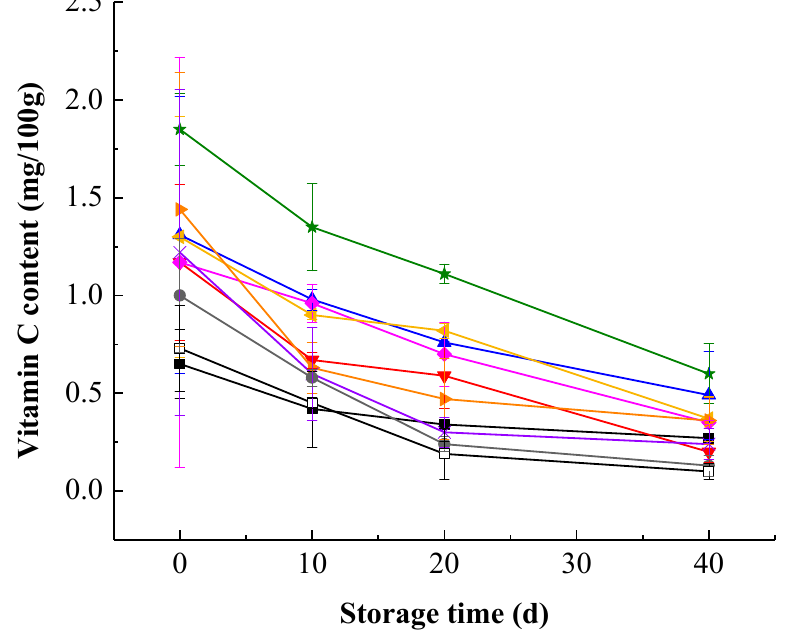
Figure 2. Changes of vitamin C content in heat-treated and HHP-treated kiwifruit pulp beverage during storage at 4 °C for 40 days. Heat treatment (85 °C for 10 min) ( ■ ), HHP (high hydrostatic pressure, 400–600 MPa for 5–15 min): 400 MPa/5 min ( ▼ ), 400 MPa/10 min ( ▲ ), 400 MPa/15 min ( ★ ), 500 MPa/5 min ( ◆ ), 500 MPa/10 min ( ◀ ), 500 MPa/15 min ( ▶ ), 600 MPa/5 min ( × ), 600 MPa/10 min ( ● ), 600 MPa/15 min ( □ ). All data were expressed as means ± SD, n = 3.